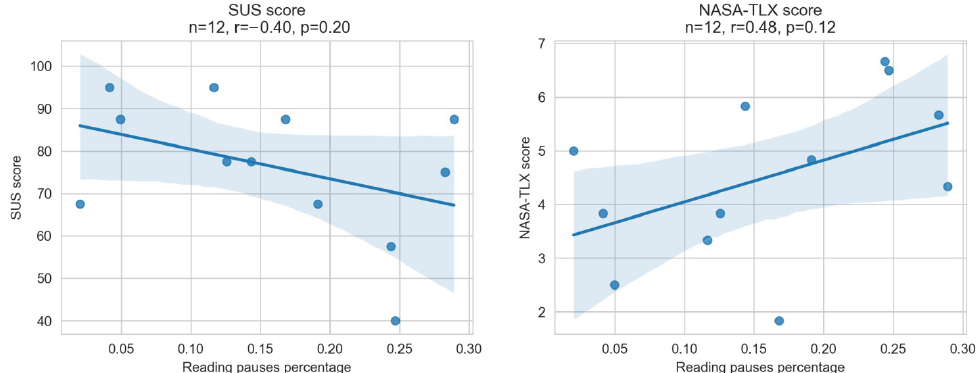
Figure 14. SUS and NASA-TLX correlated (Pearson) with the percentage of time that translations were paused during reading. The pauses percentage is the mean of the four posters.